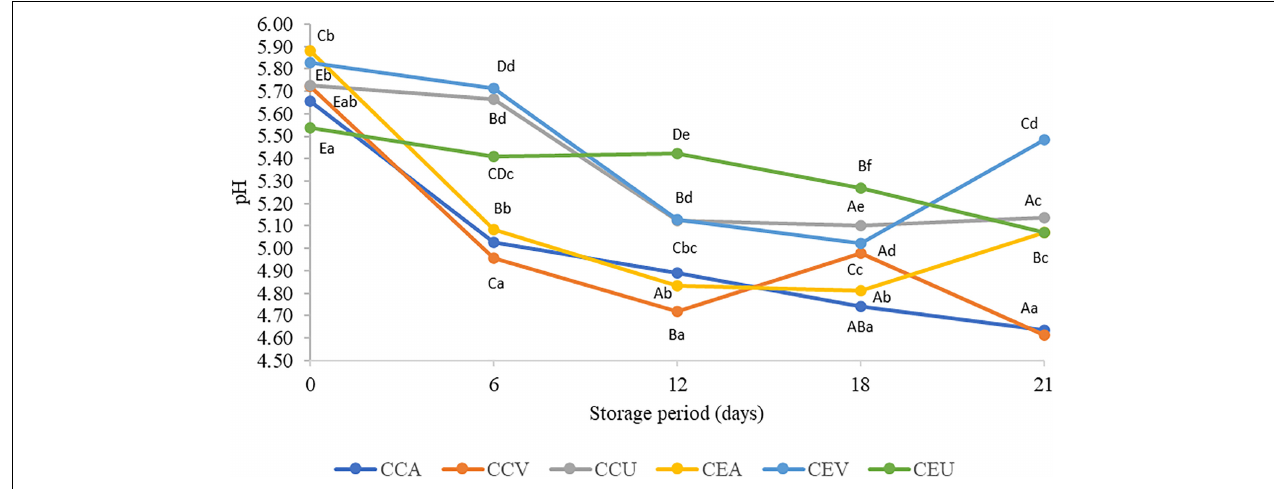
FIGURE 1 | Values of titratable acidity in raw goat milk cheeses during 21 days of storage at 4 ◦ C. CCA = raw milk cheese without extract in aerobic packaging, CCV = raw milk cheese without extract in vacuum packaging, CCU = raw milk cheese without extract in vacuum packaging + UV-C, CEA = raw milk cheese with extract in aerobic packaging, CEV = raw milk cheese with extract in vacuum packaging; CEU = raw milk cheese with extract in vacuum packaging + UV-C. A–D Different lowercase superscripts indicate significant differences among storage times ( P < 0.05). a–d Different uppercase superscripts indicate significant differences among goat milk cheeses ( P <